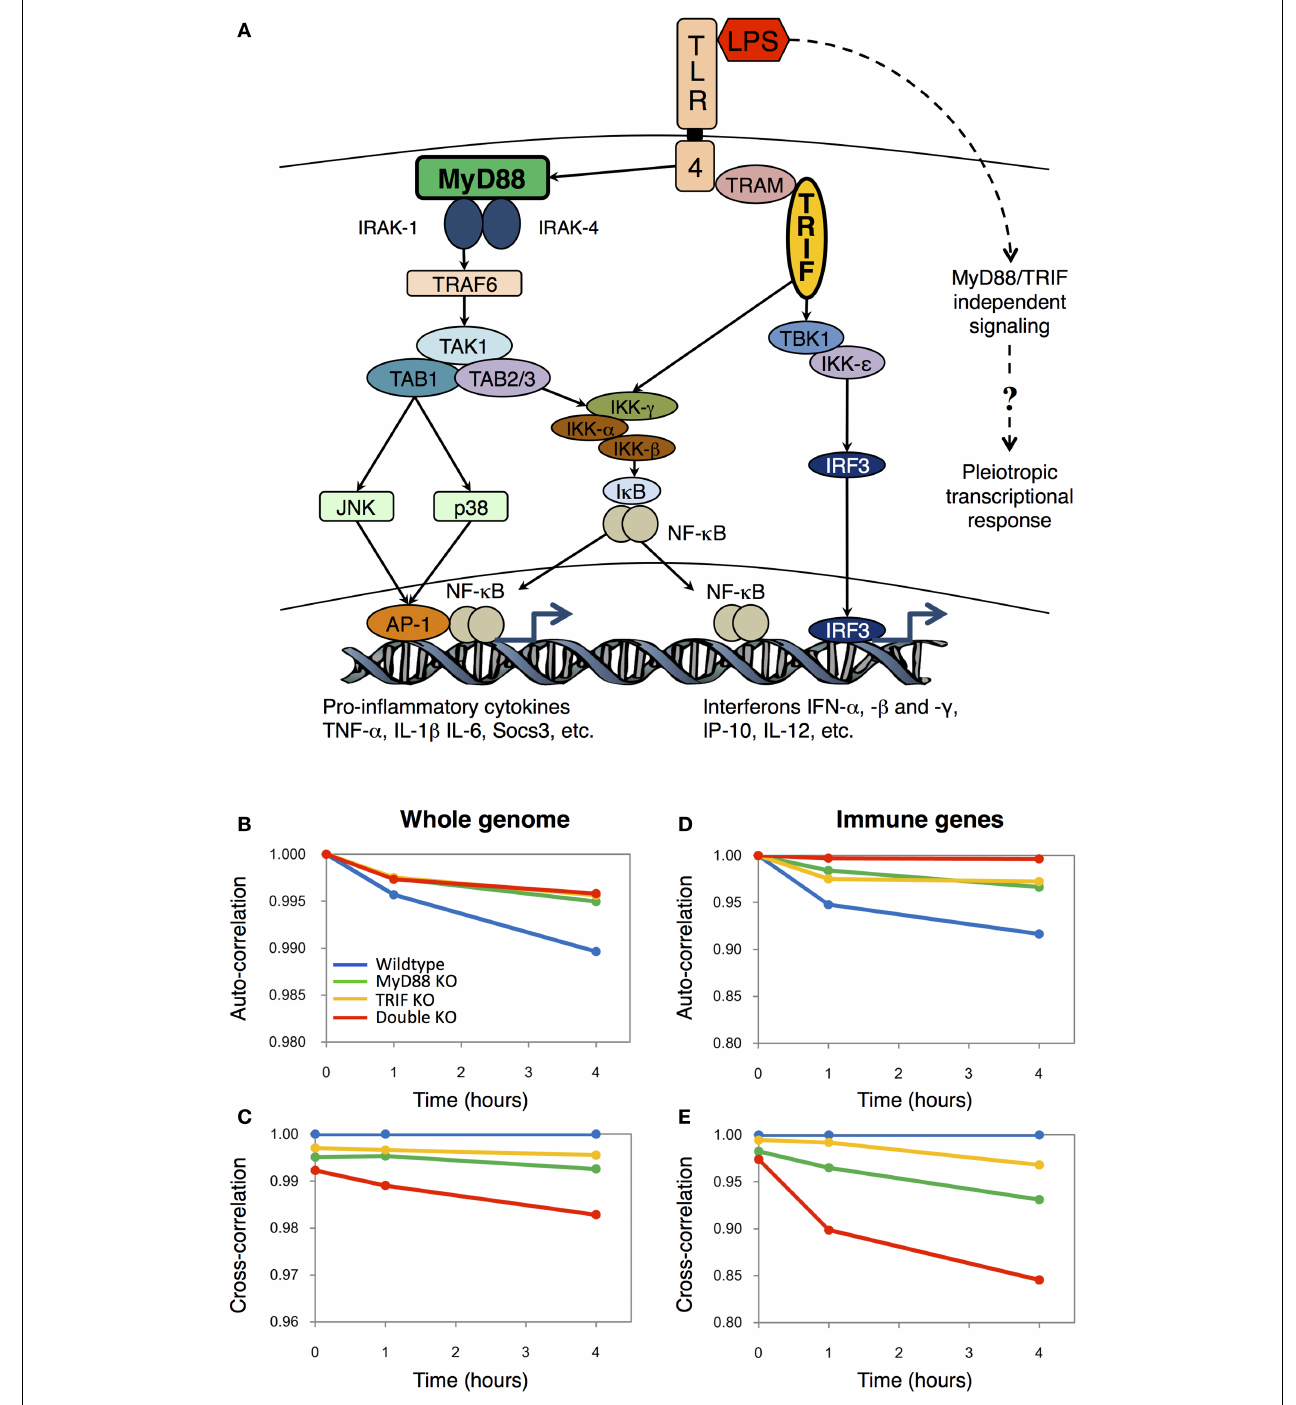
cross-correlations for whole genome (B,C) and 157 important immune genes (D,E) in LPS-stimulated murine macrophages. x -axis represents time (in hours after LPS stimulation), and y -axis represents the correlation coefficient (with t = 0h for auto-correlations, and between KO genotypes and wildtype for cross-correlations). Figure adapted from Ref.